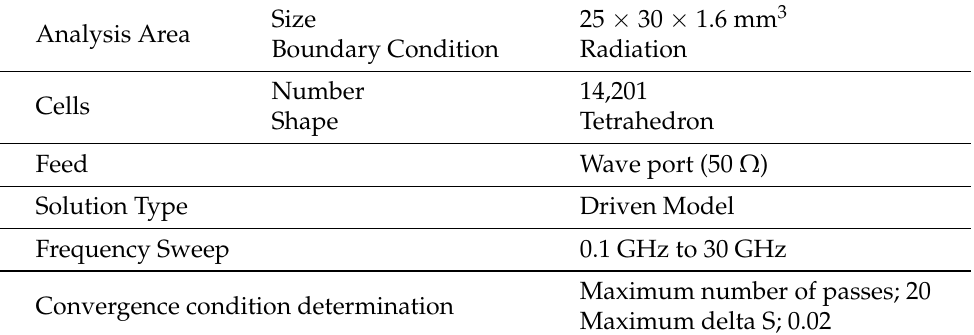
Table 1. Simulation conditions for ANSYS Electromagnetics Suite